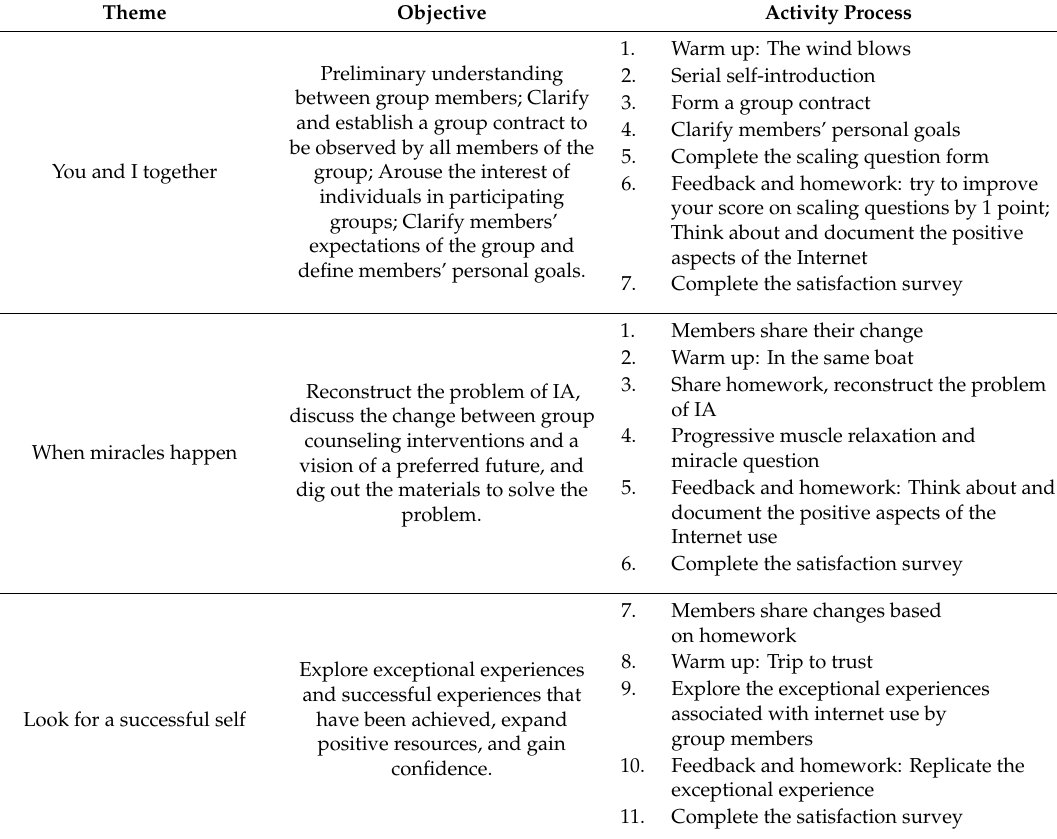
Table 1. Solution-Focused Group Counseling